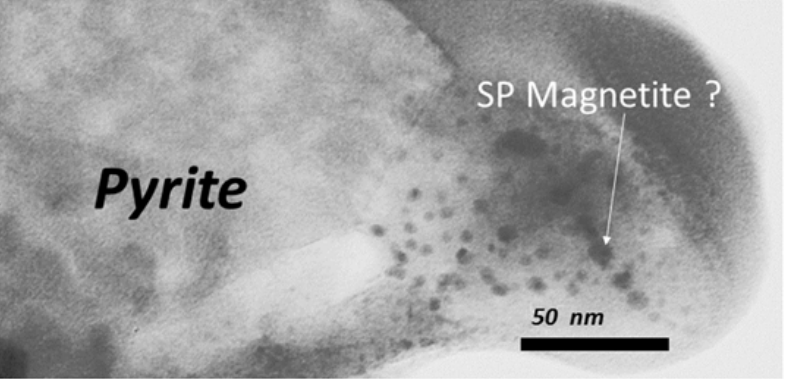
Figure 11. Transmitted electronic microscopy (TEM) microphotograph of pyrite framed by a gel in which nanometric euhedral crystals can be seen. These minerals were probably superparamagnetic (SP) magnetite